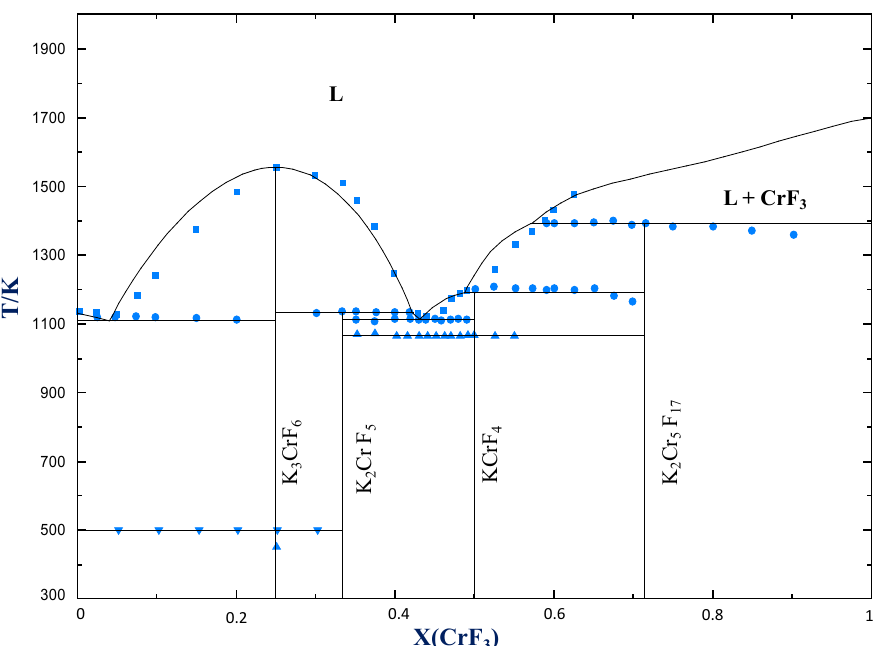
Figure 4. Phase diagram of the KF–CrF 3 system optimized in this work and comparison with the data provided by de Kozak [15]. Blue squares represent liquidus points, blue circles represent solidus points and blue triangles represent phase transition points.